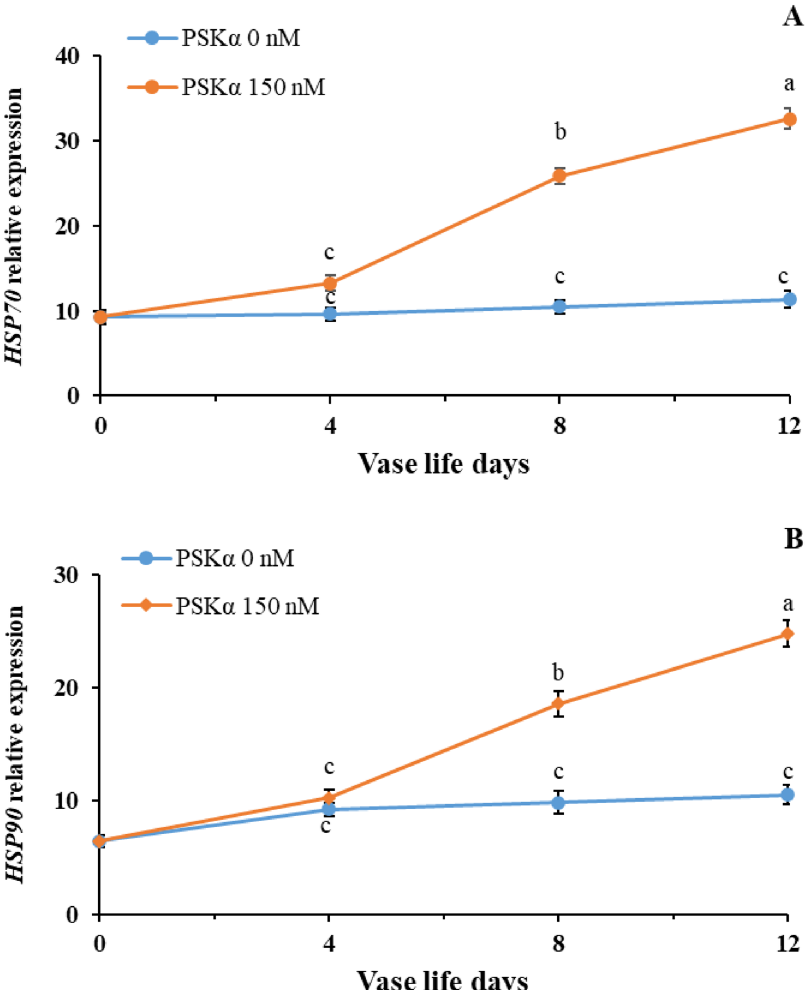
Figure 4. HSP70 ( A ) and HSP90 ( B ) genes expression in petals of rose flowers treated with PSKα at 0 and 150 nM during vase life at 20 °C for 12 days. Data shown are mean values of n = 3, and the error bars represent standard errors of the means. Mean values followed by different letters indicate they are different by LSD test at P <